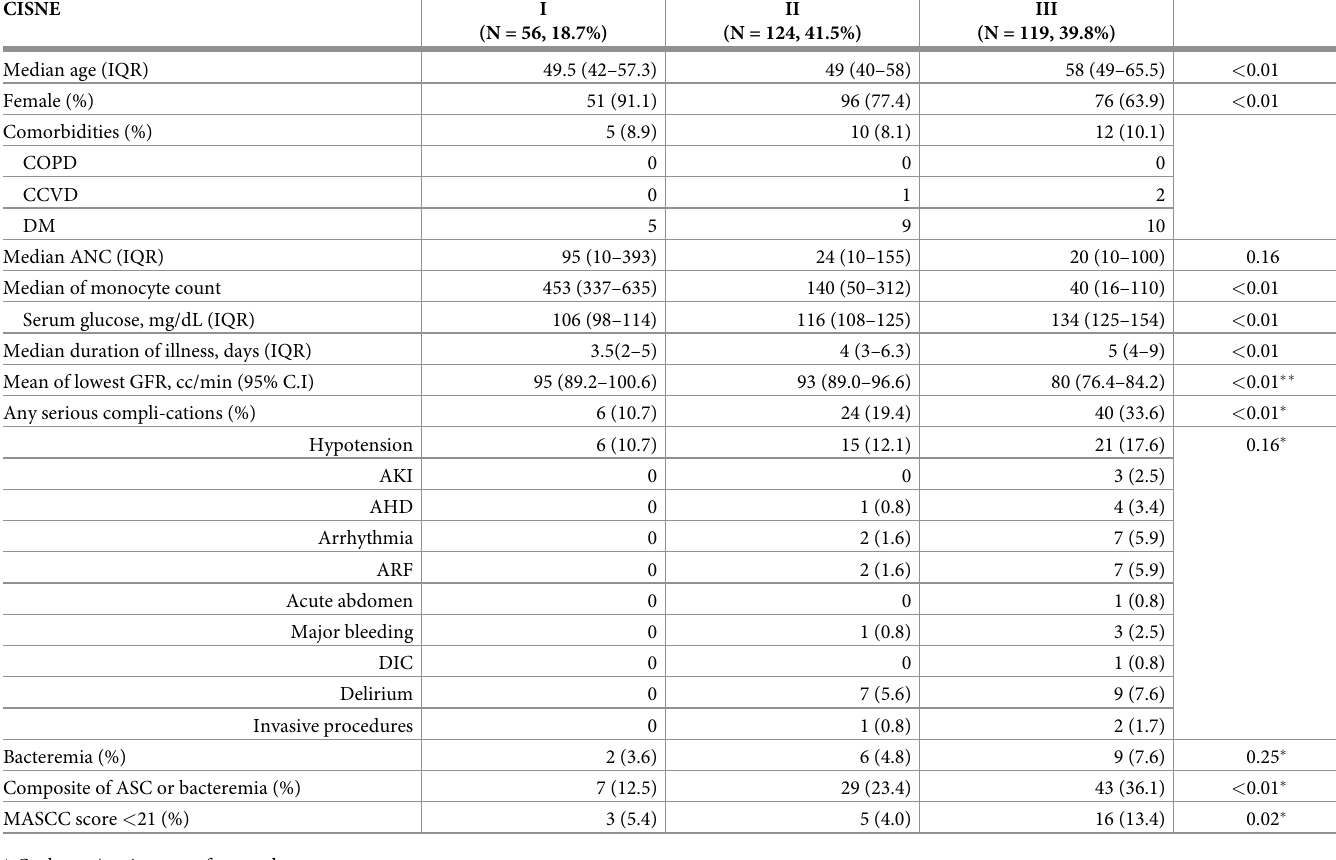
Table 2. Clinical characteristics and outcomes of 299 apparently stable patients according to CISNE triage: CISNE I (CISNE score = 0), II (score = 1 or 2), III (score � 3). Statistical tests were not applied to some individual complications that occurred at very low frequency.